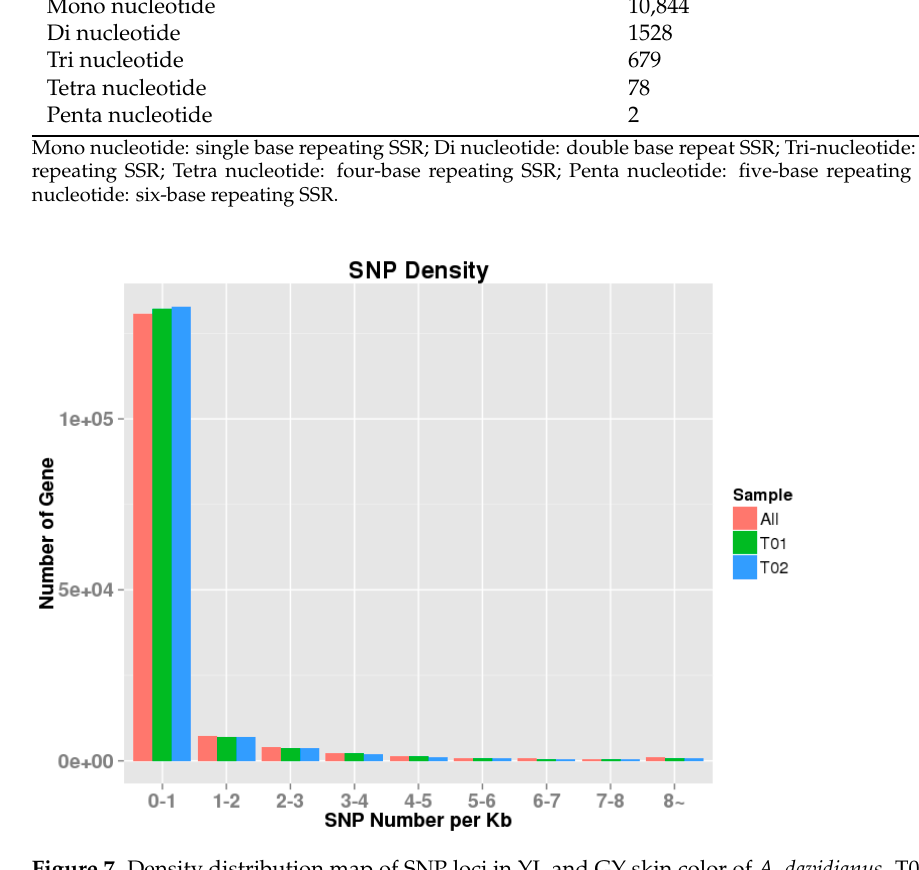
Figure 7. Density distribution map of SNP loci in YL and GY skin color of A. davidianus . T01,GY skin libraries; T02:YL skin libraries. The x -axis is SNP density, that is, the number of SNP per Kb gene sequence. The y -axis is the number of genes with the corresponding density.